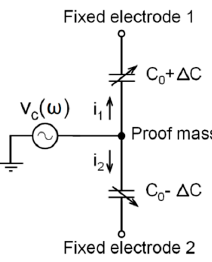
Figure 1. Electrical model of a capacitive accelerometer based on a microelectromechanical system